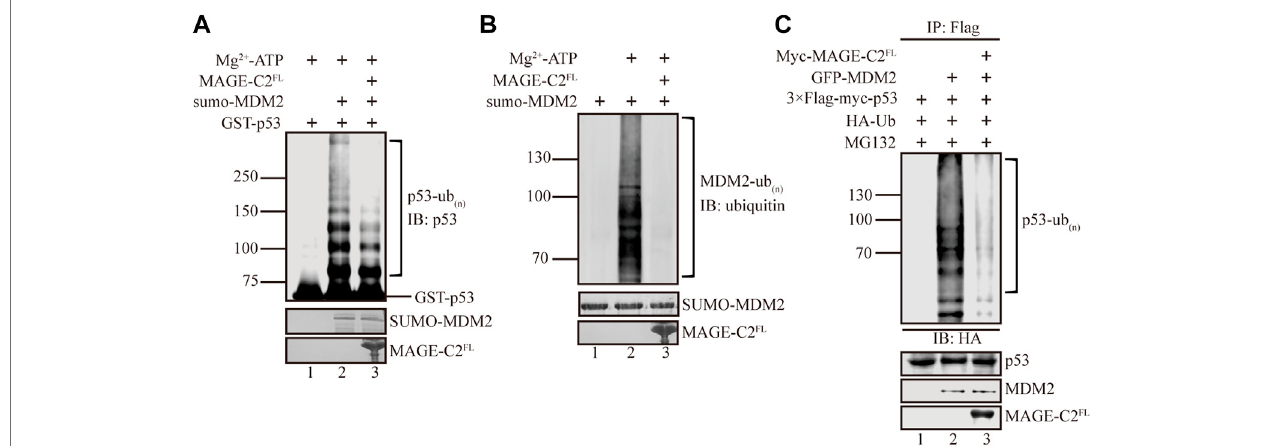
FIGURE1| MAGE-C2inhibitsMDM2-mediatedp53ubiquitination invitro andincells. (A) Invitro ubiquitinationassay.His-ubiquitin,ubiquitinE1,UbcH5BE2,Mg- ATP, GST-p53, and the indicated MAGE-C2 and MDM2 proteins were incubated for 40 min at 37 ° C and detected by using anti-p53 immunoblotting. (B) In vitro ubiquitinationassay.His-ubiquitin,ubiquitinE1,UbcH5BE2,Mg-ATP,andtheindicatedMAGE-C2andMDM2proteinswereincubatedfor40 minat37 ° C.His-ubiquitin wasdetectedbyusingantiubiquitinimmunoblotting. (C) Ubiquitinationassayincell.HEK293TcellsweretransfectedwithHA-ubiquitinandindicatedplasmids.The level of p53 ubiquitination was determined by using anti-Flag M2-agarose redbeads puri fi cation and anti-HA Western blot.